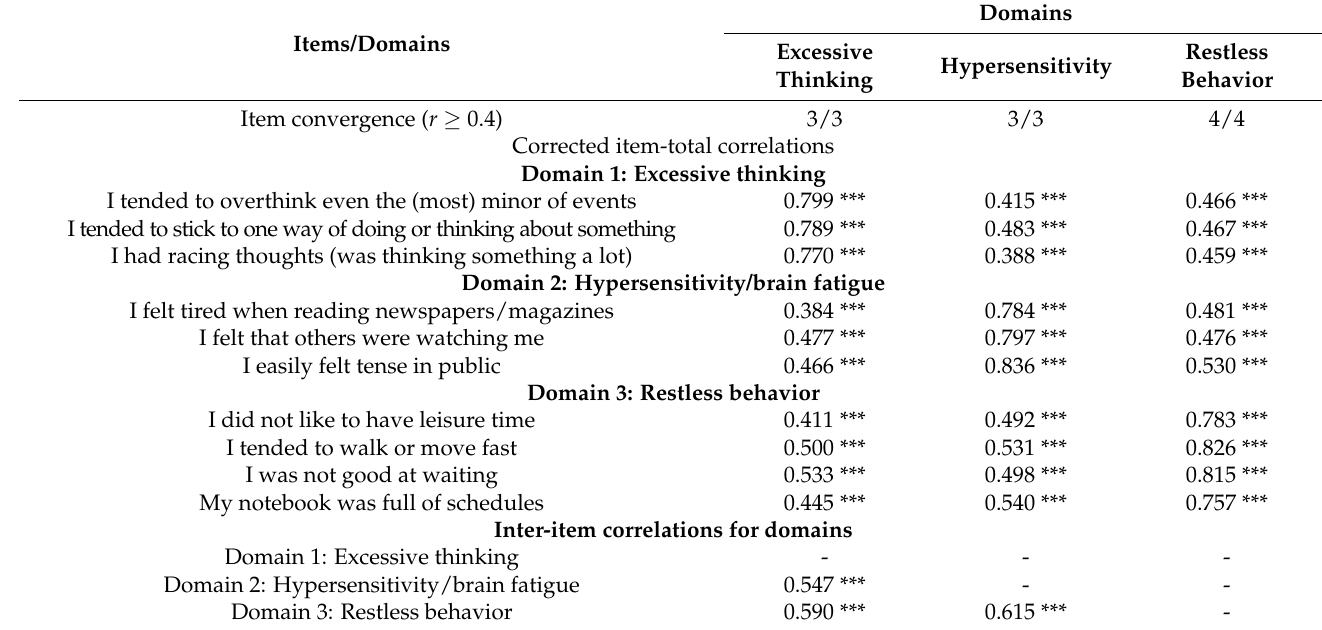
Table 6. Convergent validity of the BOS ( n = 739).